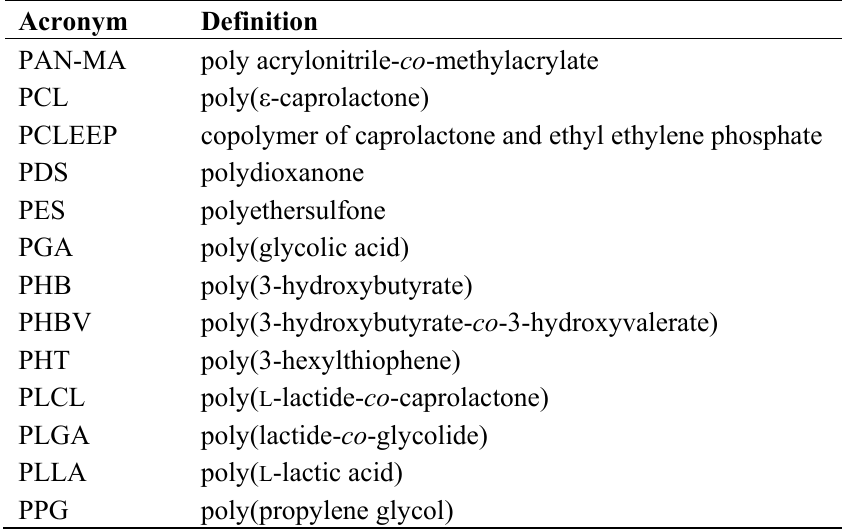
Table 1. Acronyms and definition of the most common used synthetic materials used in nanostructured electrospun